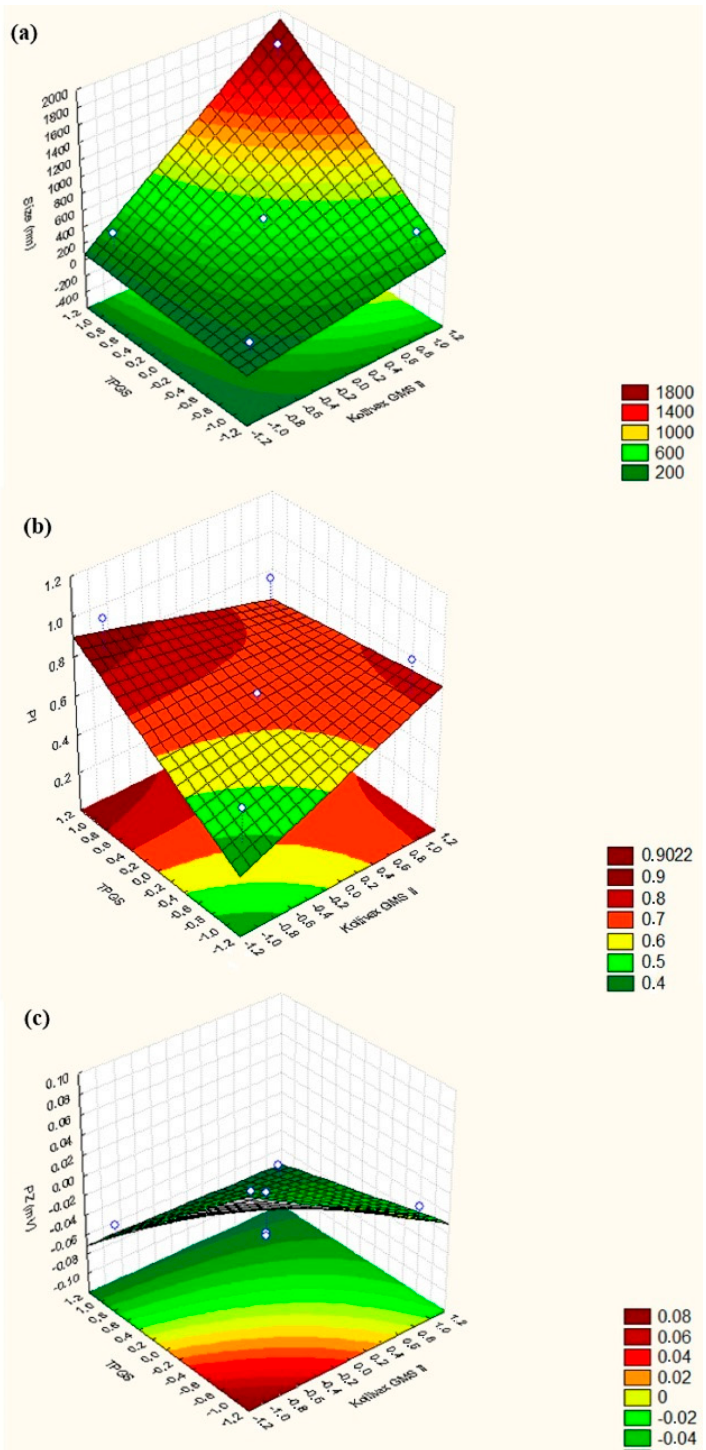
Figure 2. 3D surface response chart showing the influence of the two factors (surfactant and lipid concentrations) on the ( a ) mean particle size, ( b ) PI, and ( c ) ZP of sucupira oil-loaded NLC. The EE of sucupira oil-NLC (formulation no. 6) was found to be 99.98% and the LC 9.6%. These results were expected and were attributed to the high affinity of the oil with the solid lipid (Kollivax ® GMS II) selected by lipid screening assay. The obtained values are typical for oils loaded into